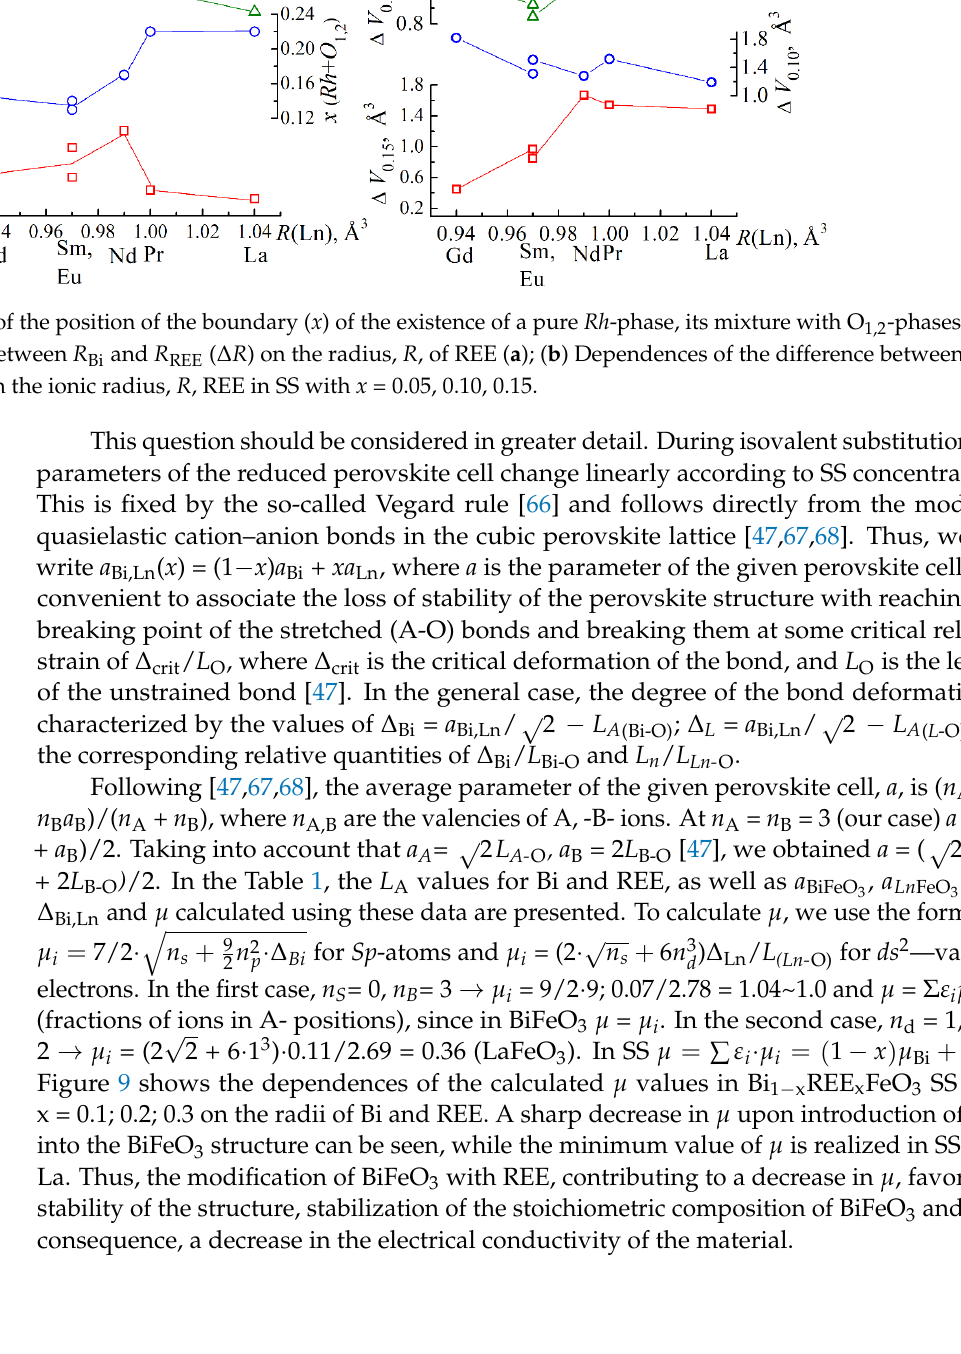
Table 1. Main crystal chemical characteristics of A-elements (A-Bi, La, Pr, Nd, Sm, Eu, Gd, Ho). A-Element R , Å μ , rel. Units